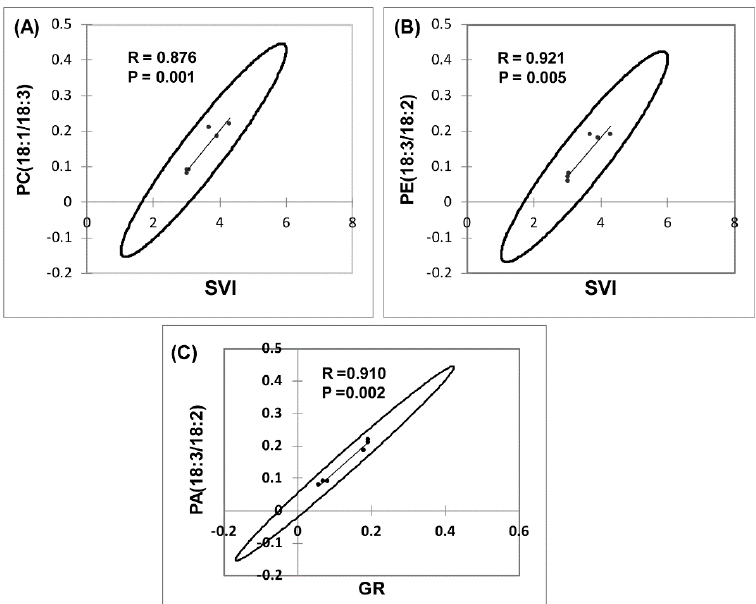
Figure 9. Correlation of lipid molecular species with seedling vigor index (SVI) and germination rate (GR) in dormant upland boreal forest species. Correlation between PC(18:1/18:3) and SVI ( A ), PE(18:3/18:2) and SVI ( B ) and PC(18:3/18:2) and GR ( C ). Means of the treatments used for MWCNT–COOH are presented, N = 100 plants per treatment. PC = phosphatidylcholine, PA = phosphatidic acid, PE = phosphotidylethanolamine.